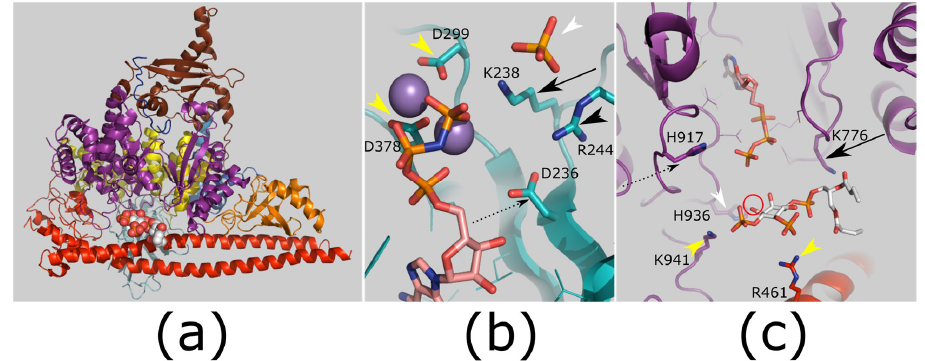
Figure 6. Structure and mechanism of PtdIns kinases. ( a ) Overview of PtdIns-3-kinases (PI3K) complex with substrate. PI3K is shown as cartoon, with domains shown in different colors (kinase domain: purple; regulatory subunit: red). Substrate PIP2 shown in spheres (white carbons). PDB ID: 4OVV [130]. ( b ) Proposed mechanism for PIP5K activity. Protein structure is shown in teal; Ligands AMP-PNP (carbons pink; substrate analog), selenate (orange selenium, white arrowhead; analog of sugar phosphate group) and manganese (purple spheres). A conserved lysine (black arrow; K238) and arginine (black arrowhead; R244) coordinate the substrate phosphate, and are essential for